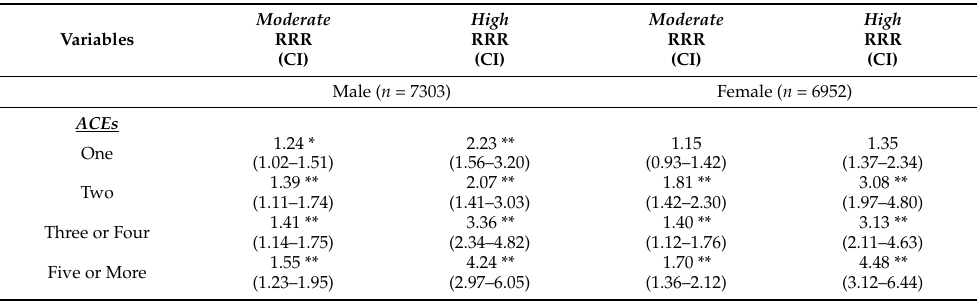
Table A2. Multinomial logistic regression models of the association between ACEs and cardiovascular risk among young adults stratified by sex, race, age, and urbanicity.